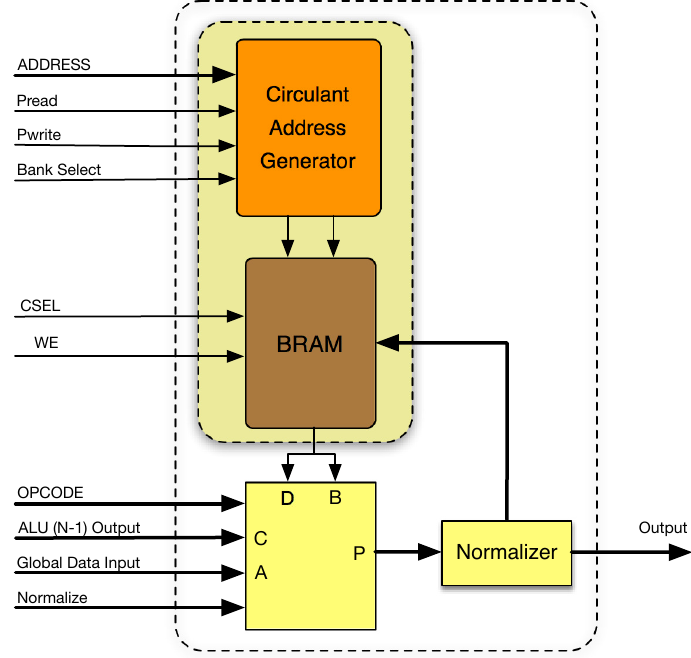
Figure 3. Single ALU-RAM column interconnection structure. The RAM block is divided logically into two equal banks, one storing the current operand and the other saving the result of